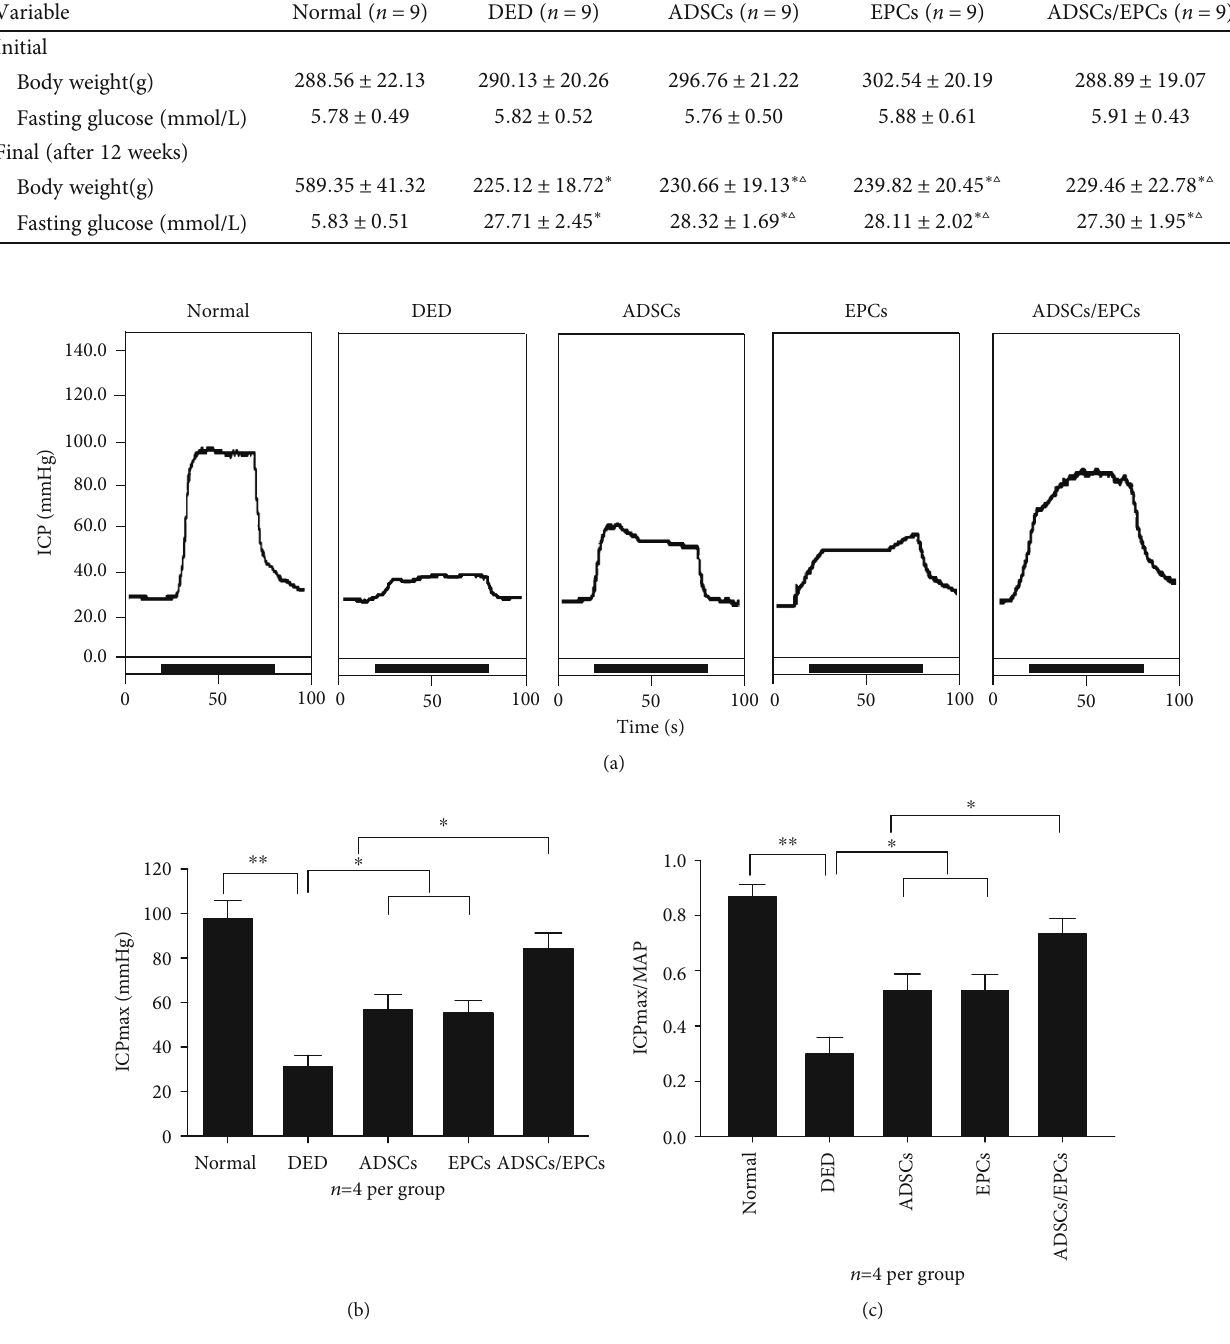
Figure 3: Combined transplantation of ADSCs and EPCs improved erectile function in the DED rats. (a) Representative ICP tracing response to the electronic stimulation of the cavernous nerve (5 V, 20 Hz, and 60s duration) in DED rats after injection of PBS, ADSCs, EPCs, or ADSCs/EPCs ( n = 4 rats per group). (b) The e ff ects of ADSCs, EPCs, and ADSCs/EPCs on the increase of ICP in the DED rats. (c) The ratio of total ICP to MAP was calculated for all fi ve groups. ∗ p < 0 : 05 , ∗∗ p < 0 : 01 . ICP: intracavernous pressure; MAP: mean arterial pressure; PBS: phosphate-bu ff ered